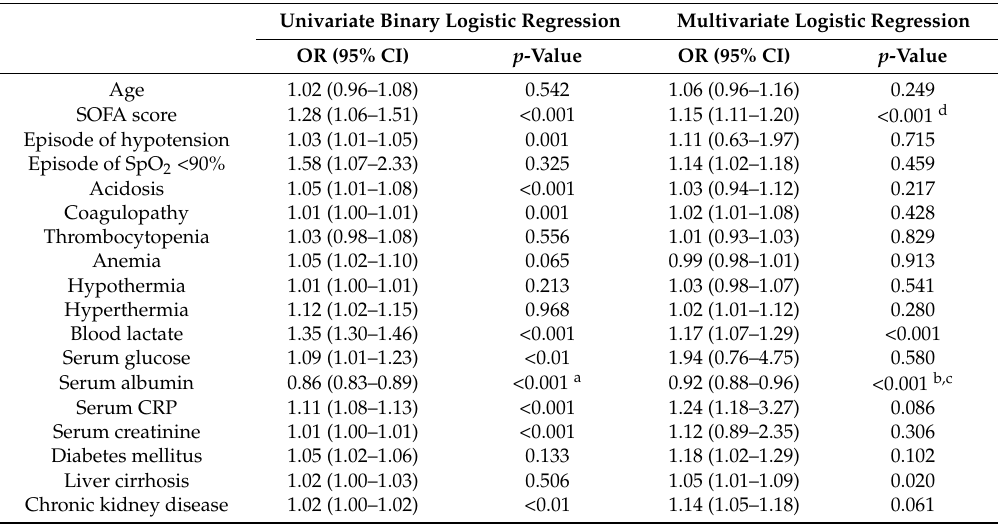
Table 3. Univariate and multivariate logistic regression analyses of variables potentially associated with in-hospital mortality in